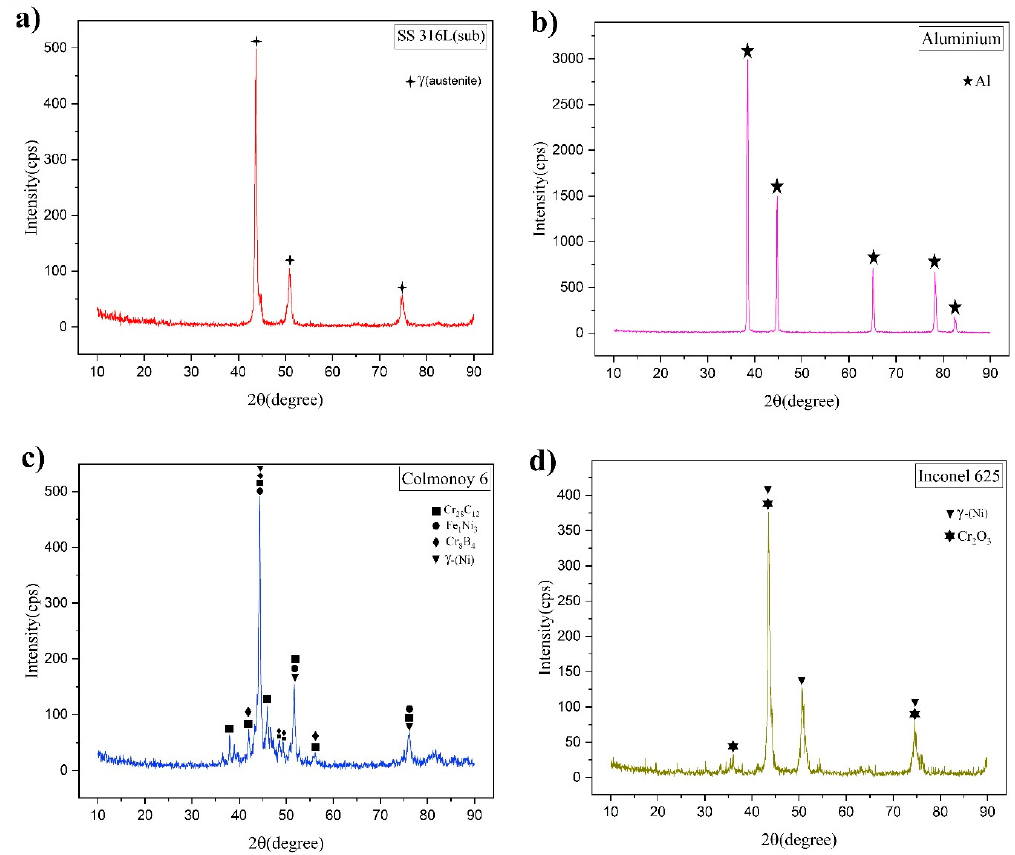
Figure 1. XRD of ( a ) SS 316 L, ( b ) aluminum, ( c ) Colmonoy-6, and ( d ) Inconel 625.